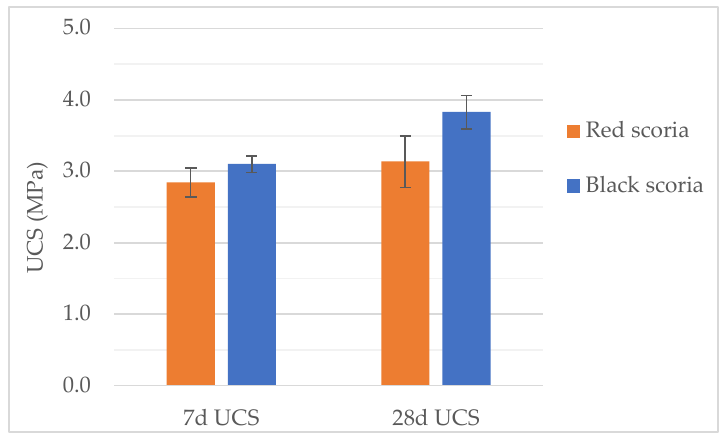
Figure 8. UCS of the red CTS and black CTS after 7 and 28 days of curing.